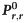
Detection rates against Pr,r0 for count communication data with |V| = 20 and two communities.P1,1′=(1+0.5)×P1,10.